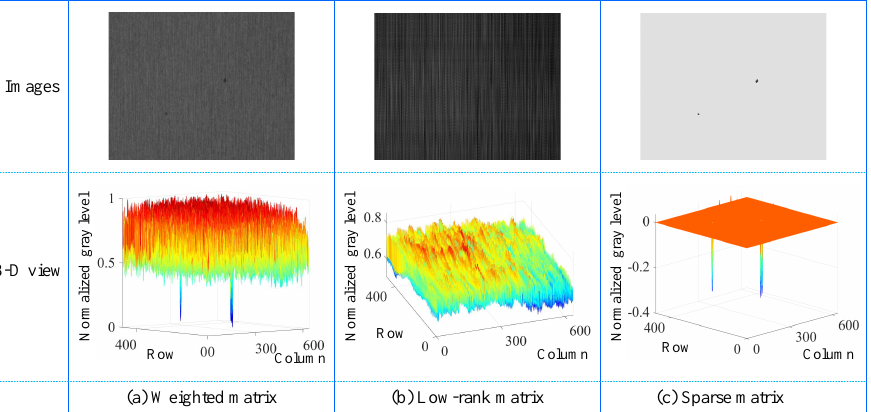
Figure 5. Matrix decomposition in multiple-defect images. The first column is a weighted matrix, which is decomposed into low-rank (in second column) and sparse matrices (in third column), re-